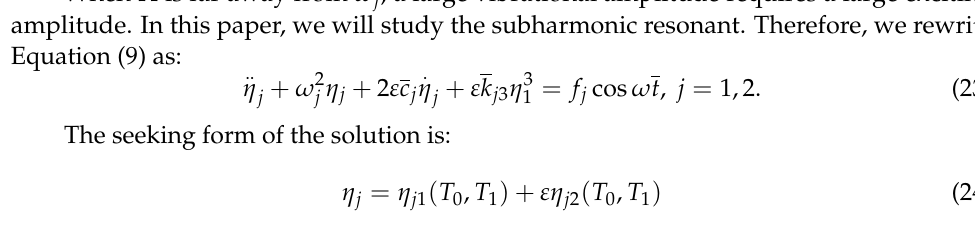
Figure 9. Excitation amplitude response curves of the second mode with